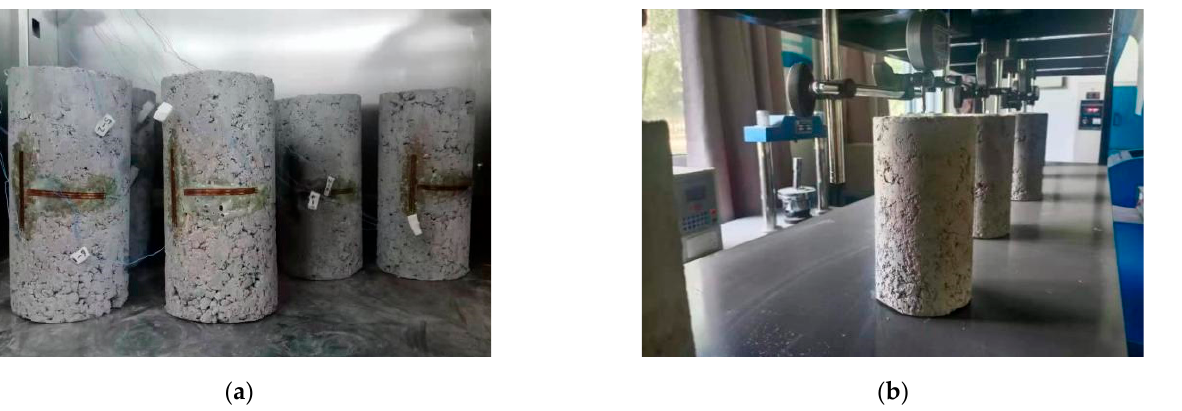
Figure 1. Shrinkage test: ( a ) Temperature shrinkage test, ( b ) Dry shrinkage